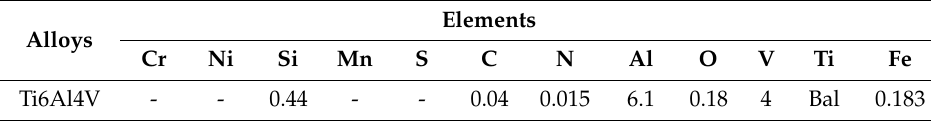
Table 2. Chemical composition of Ti6Al4V alloy (wt.%).